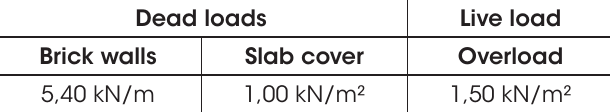
Vertical loads applied on the idealized structures Dead loads Live load Brick walls